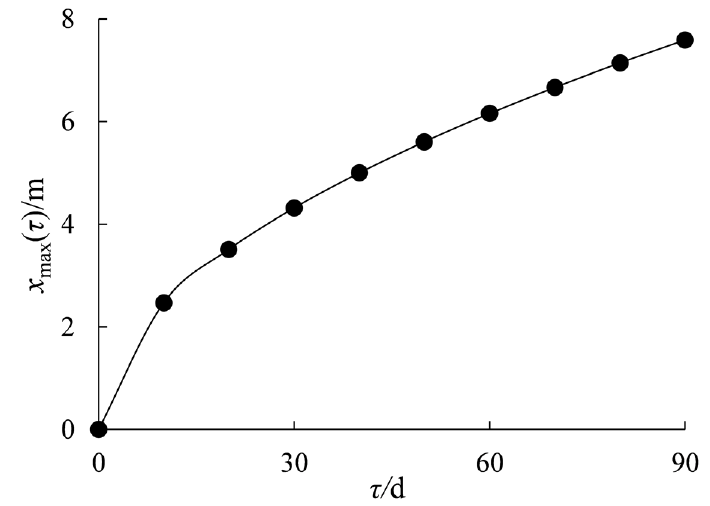
Figure 3. The curve of x max ( τ ) with inertia time τ .